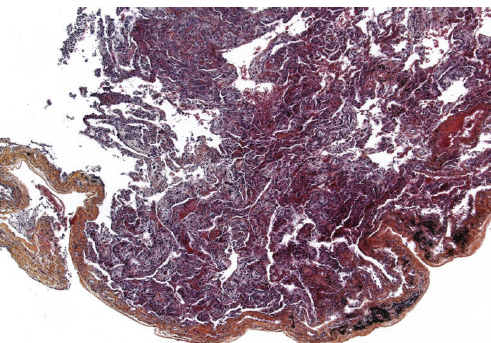
Figure 3: Open lung biopsy performed on day 6 (HES × 50): lesions of bronchiolitis obliterans with organizing fibroblastic polyps in alveoli.